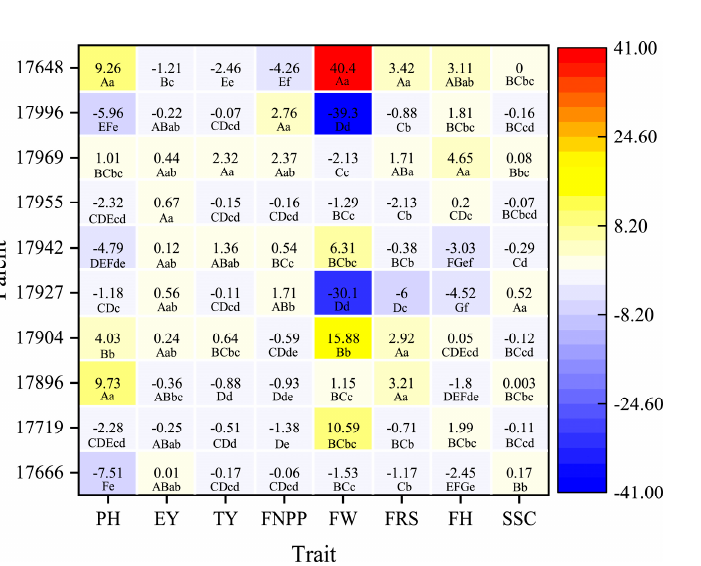
Figure 3. General combining ability (GCA) effects in parents for eight main agronomic traits. The vertical axis represents the different parents, and the horizontal axis represents the different traits. The combining ability is coded according to the color key plotted on the right. The blue and red boxes indicate negative and positive combining ability, respectively. For each trait, the parents were compared with each other. In the boxes, different numbers indicate the values of the GCA effects, while lowercase letters and uppercase letters indicate significance at 0.05 and 0.01 probabilities,